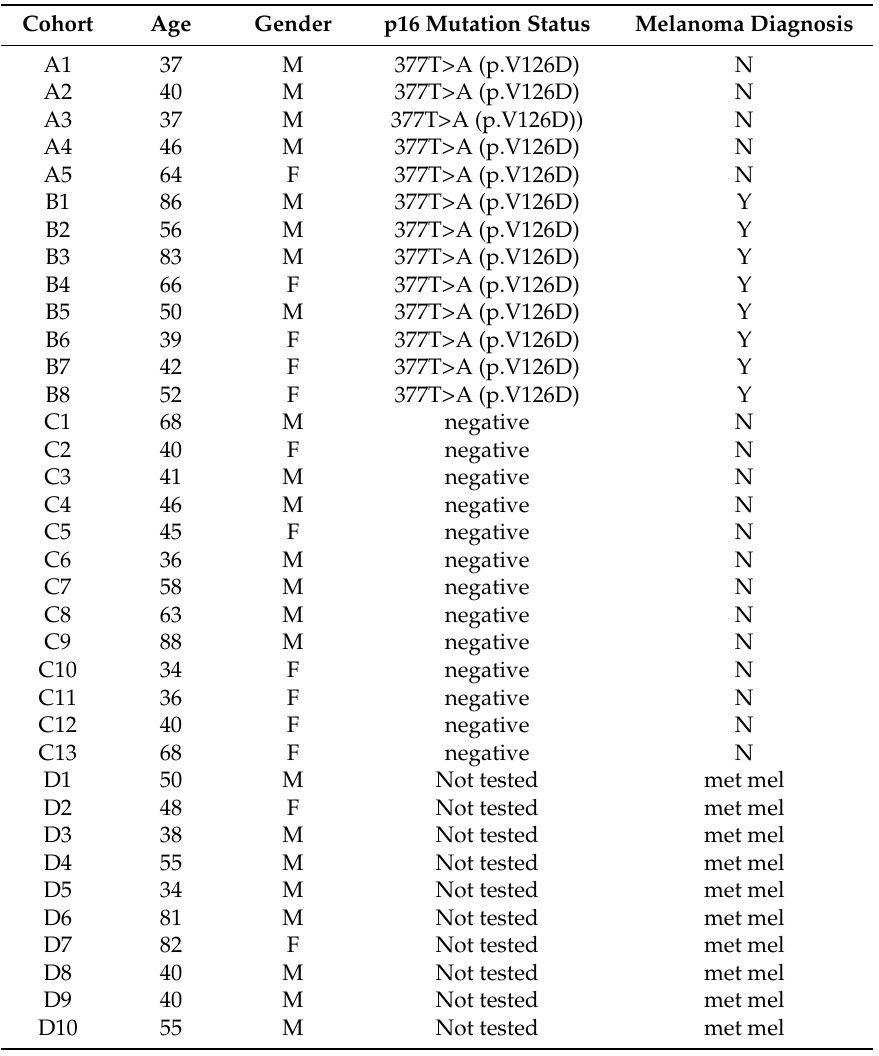
Table 1. General patient